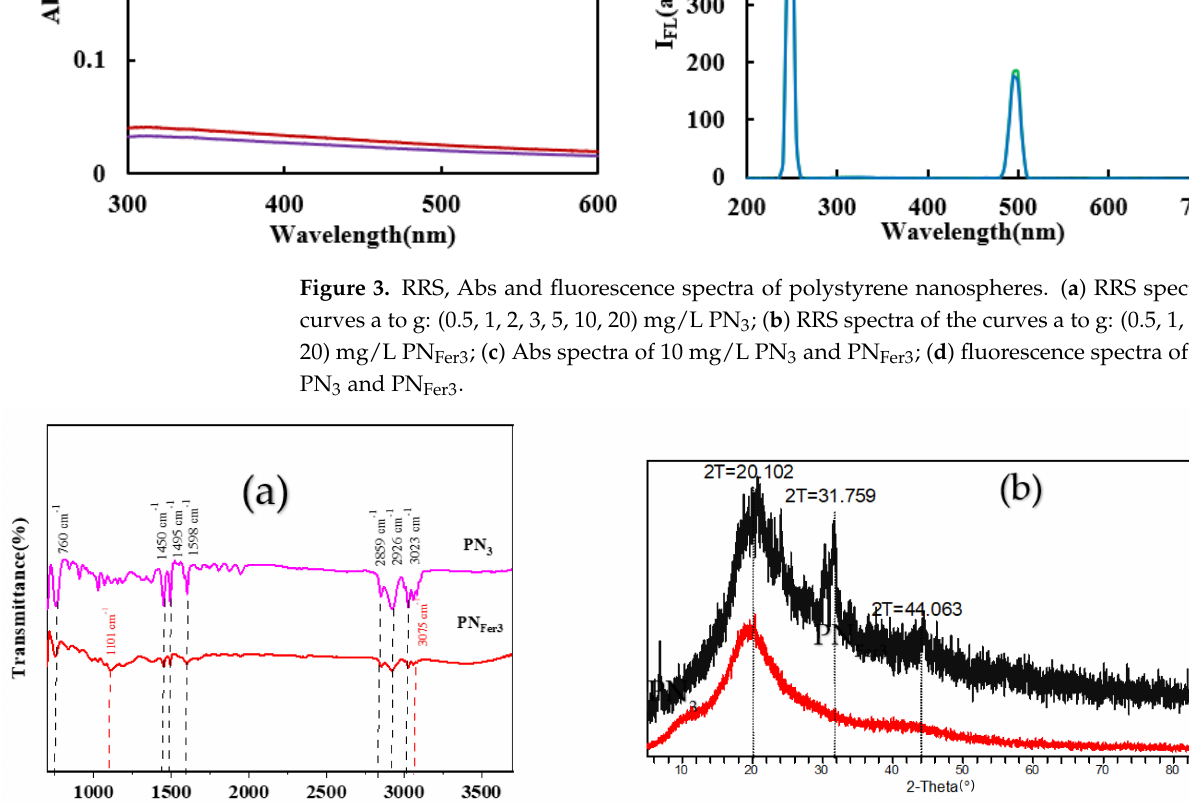
Figure 4. Infrared spectra and XRD pattern of polystyrene nanospheres. ( a ) Infrared spectra of PN 3 and PN Fer3 ; ( b ) XRD of PN 3 and PN Fer3 .